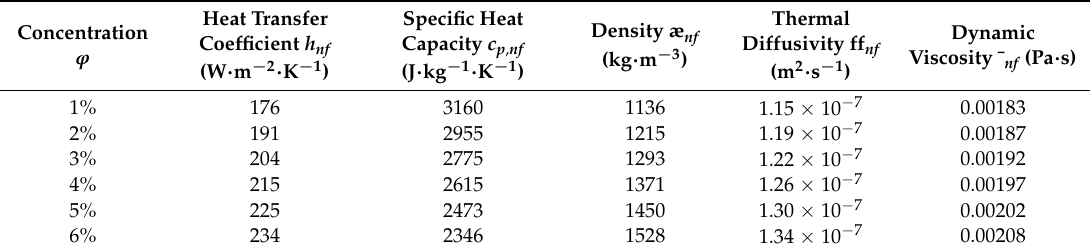
Table 3. Computational parameters of Cu-Ethylene glycol (Cu-EG) nanofluid under different concentrations.